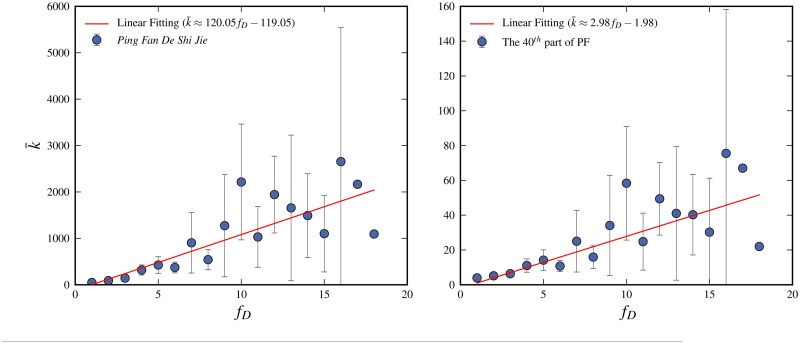
The average frequency k‾ for the occurrence of a Chinese character in a given text is plotted against its number of multiple dictionary meanings f
D.The Chinese character dictionary Xinhua Dictionary, 5th Edition is used for the number of dictionary meanings of Chinese characters. Figure (a) shows the occurrence in the novel Ping Fan De Shi Jie and figure (b) the occurrence for the average 40th-part of the same novel. In both cases the trend of the functional dependence can be represented by a straight line. The linear increase fD∝c′k‾ is for the full novel c′ ≈ 0.0083 and for the 40th-part c′ ≈ 0.34. The reason that c′ increases with decreasing size is explained in the text.